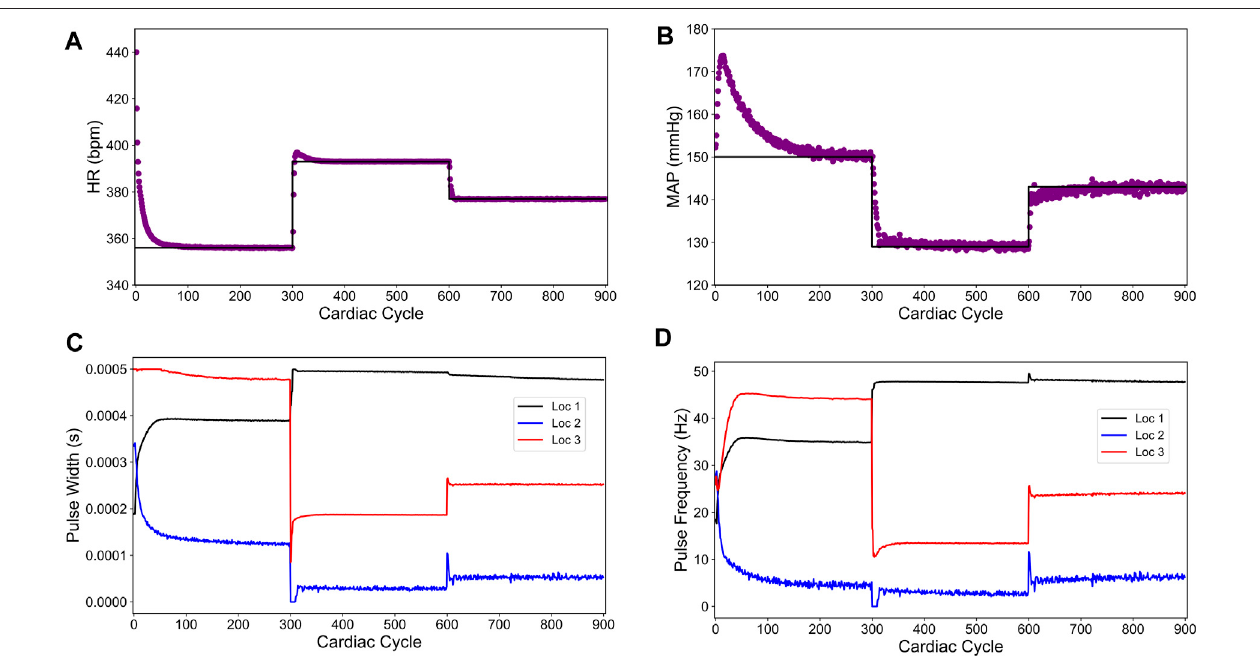
FIGURE10| Offset-freeclosed-loopcontroloftheheartrate(HR)andthemeanarterialbloodpressure(MAP)inan insilico overactivesympatheticsystemmodelof the rat cardiac system. (A) and (B) show the closed-loop control response from the modi fi ed in silico physiological model (shown in purple dots) and the target (or reference)forthecontroller(showninblackline)forHRandMAP,respectively. (C) and (D) showthepulsewidthandthestimulationfrequency,respectively,designedby the controller at each VNS